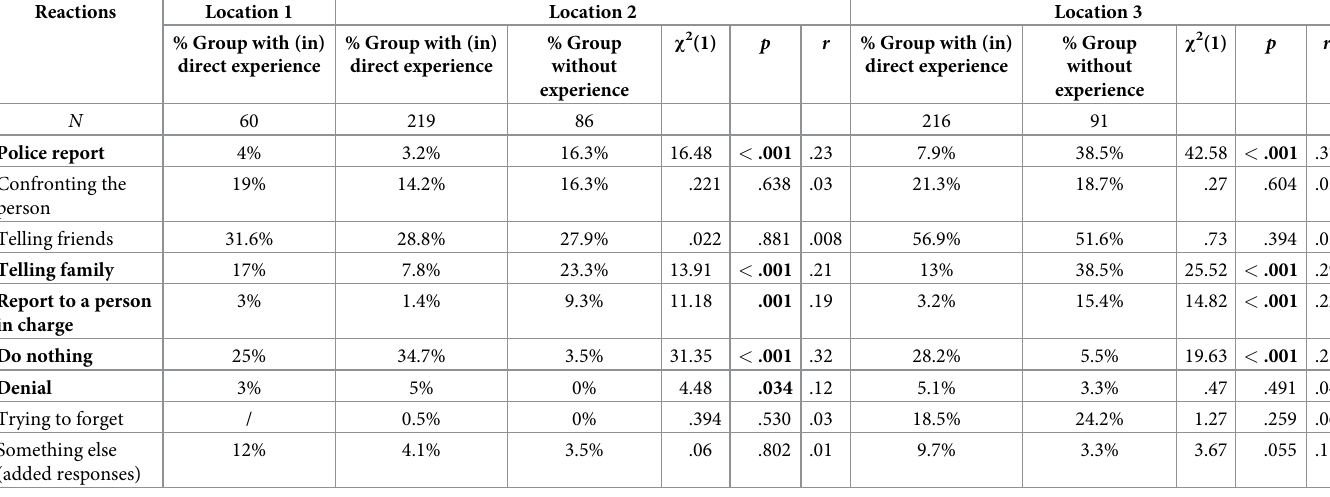
Table 4. Frequency of selected reactions at Location 1, Location 2 (among students with direct and indirect experience), and Location 3 (among students with direct and indirect